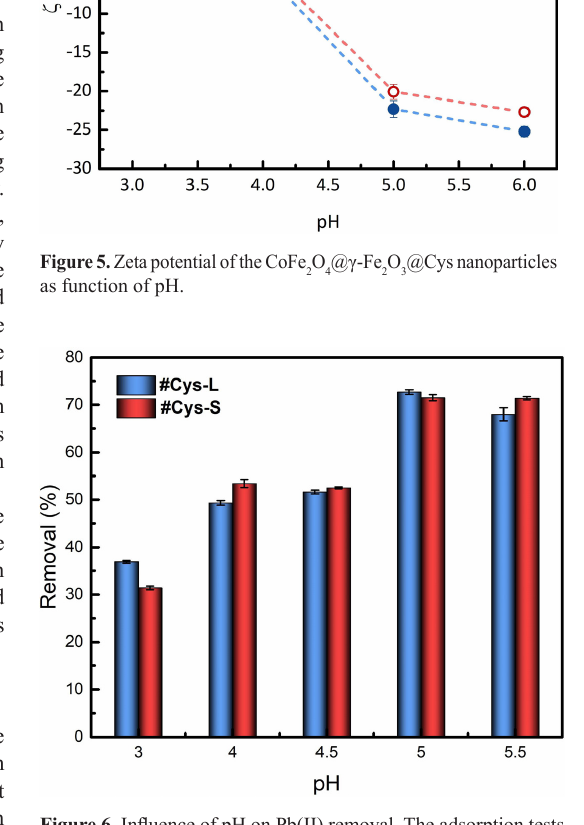
Figure 6. Influence of pH on Pb(II) removal. The adsorption tests were performed for 2.5 mg/L of Pb(II) solution, contact time of 240 minutes and at 25